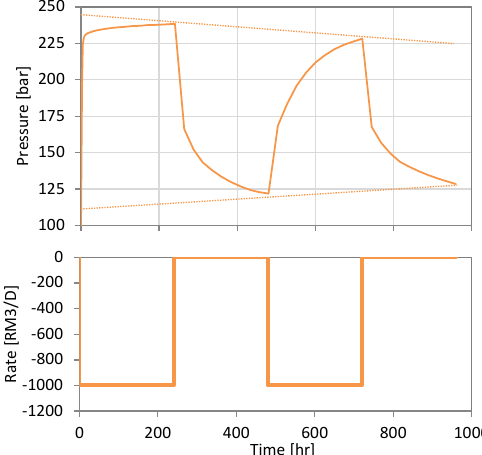
Figure 7. Pressure ( left ) and CO 2 saturation ( right ) distributions in 1D radial simulations in Eclipse (the radius of the simulated area is 1000 m). Pressure scale adjusted to highlight the buildup area, all values below 155 bar marked with blue.